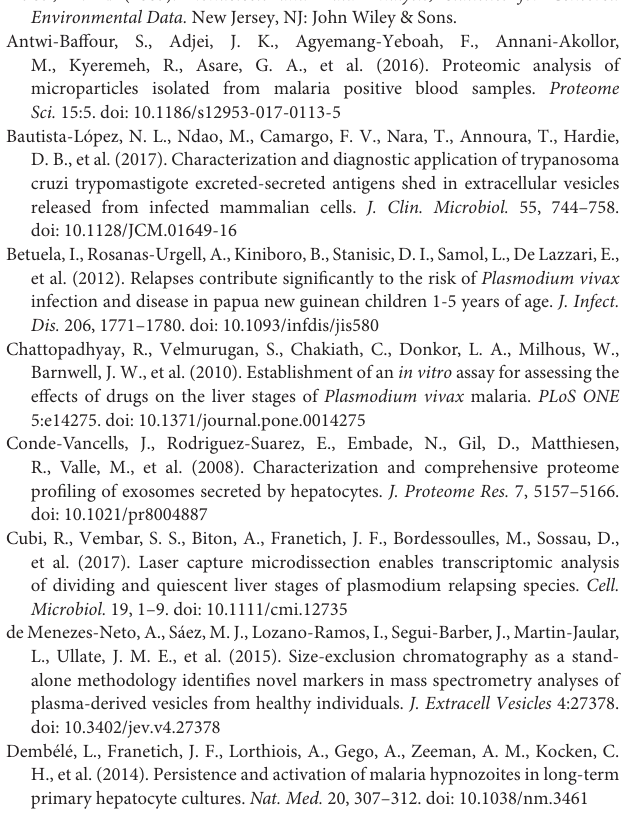
Figure S2 | Molecular characterization of SEC fractions was done through flow cytometry bead-based analysis of the CD5L marker. (A) Experimental infection 1 (EI1). Isolation of exosomes from the plasma of P. vivax infected FRG HuHep mice was performed 8 days post infection (dpi). There were 6 infected mice (M1-M6) and 4 uninfected mice (M1-M4). (B) Experimental infection 2 (EI2). Isolation of exosomes from plasma of P. vivax infected FRG HuHep mice at 8 (2 mice: M1-M2), 10 (2 mice: M1-M2), 16 (2 mice: M1-M2), and 21 (1 mouse) dpi. Images show that CD5L-positive-exosomes were enriched in fractions 7 − 10. Based on this profile, an exosomal enriched fraction (ExEF) and a plasma-microvesicles enriched fraction (MvEF) were made by pooling fractions F7-F8-F9-F10 (black dashed square) and fractions F5-F6-F11-F12 (red dashed square), respectively. Blue circles: CD5L signal, Purple squares: negative control (Fractions + rabbit-isotype + Alexa488-2 a antibody, Black diamonds: Protein concentration. Data Sheet S1 | Characterization of P. vivax infection in liver tissue from FRG huHep infected mice. Data Sheet S2 | Mass spectrometry data of H. sapiens, Mus musculus and P. vivax proteins identified in ExEFs. Data Sheet S3 | Statistical analysis of H. sapiens proteins identified in the ExEFs and MvEFs and in the ExEFs of infected and uninfected mice from Experimental infection 1. Data Sheet S4 | Gene ontology enrichment analysis of H. sapiens proteins identified in the ExEFs of FRG huHep P. vivax infected mice. Data Sheet S5 | Global comparison of H. sapiens proteins identified in the ExEFs of P. vivax infected FRG huHep mice with the core proteins identified in the previously published proteomes of hepatocytes-derived